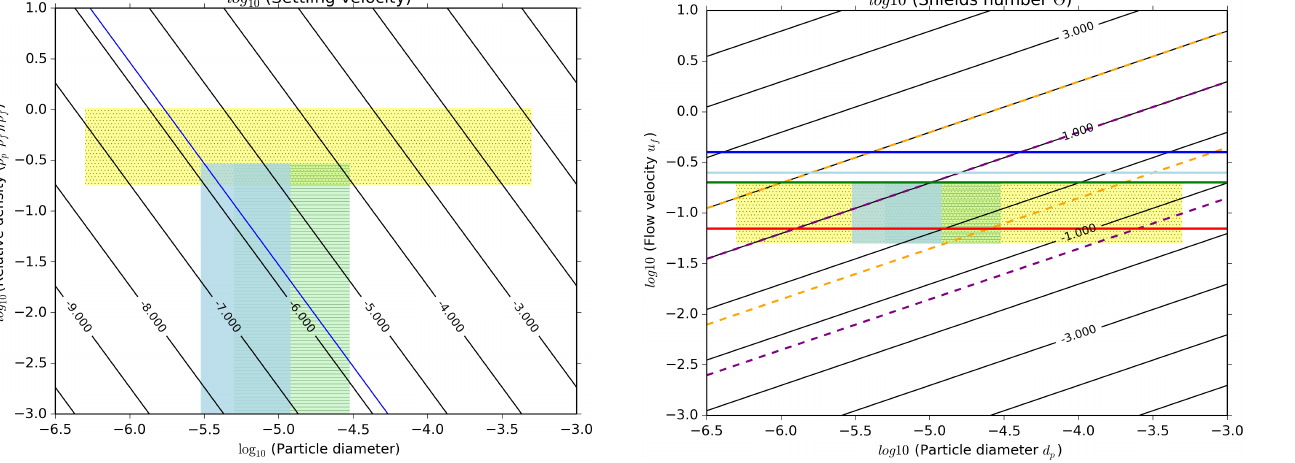
Figure 3. Contour plot of the Shields number as a function of the average flow velocity ¯u f and particle diameter d p . The blue, green-striped, and yellow-dotted rectangles show common Dutch, UK, and Australian drinking water conditions, respectively (see Ta- ble 2 and the text for explanation). Blue, light-blue, green, and red lines indicate proposed upper limits of self-cleaning velocities of 0.4 (Vreeburg, 2008) and 0.25ms − 1 (Blokker et al., 2010), and the default resuspension (0.2ms − 1 ) and deposition (0.07ms − 1 ) veloc- ities for Australian DWDSs (Ryan et al., 2008). As mentioned in the text, the critical Shields numbers for incipient motion, θ c , are estimated to vary between 0.05 and 10 (log 10 -values between − 1.3 and 1). The resuspension threshold is θ rs ≈ 10 θ c (see text) and thus varies between 0.5 and 100 (log 10 -values of − 0.3 and